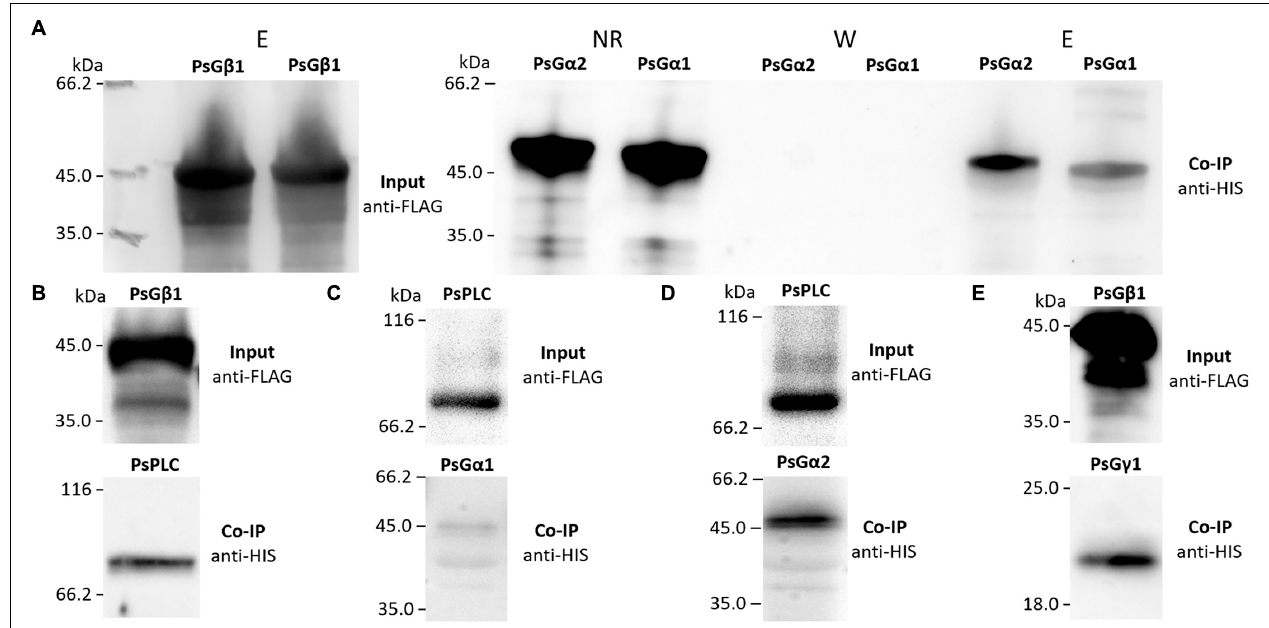
FIGURE 5 | The result of co-immunoprecipitation of heterotrimeric G-protein subunits and phospholipases C (PsPLC) and D (PsPLD) from P. sativum . A heterologous protein expression was carried out in E. coli C41. Co-immunoprecipitation of PsG beta 1 with PsG alpha 1 and PsG alpha 2 (A) as well as PsG beta 1 with PsPLC (B) . PsPLC interacts with PsG alpha 2, but does not interact with PsG alpha 1 (C,D) . The interaction was detected between PsG beta 1 and PsG gamma 1 (E) . Eluted proteins were separated in 12% polyacrylamide gels and then transferred to nitrocellulose membrane for subsequent Western blot analysis. E – elution, NR – non-retained fraction, W – washing.